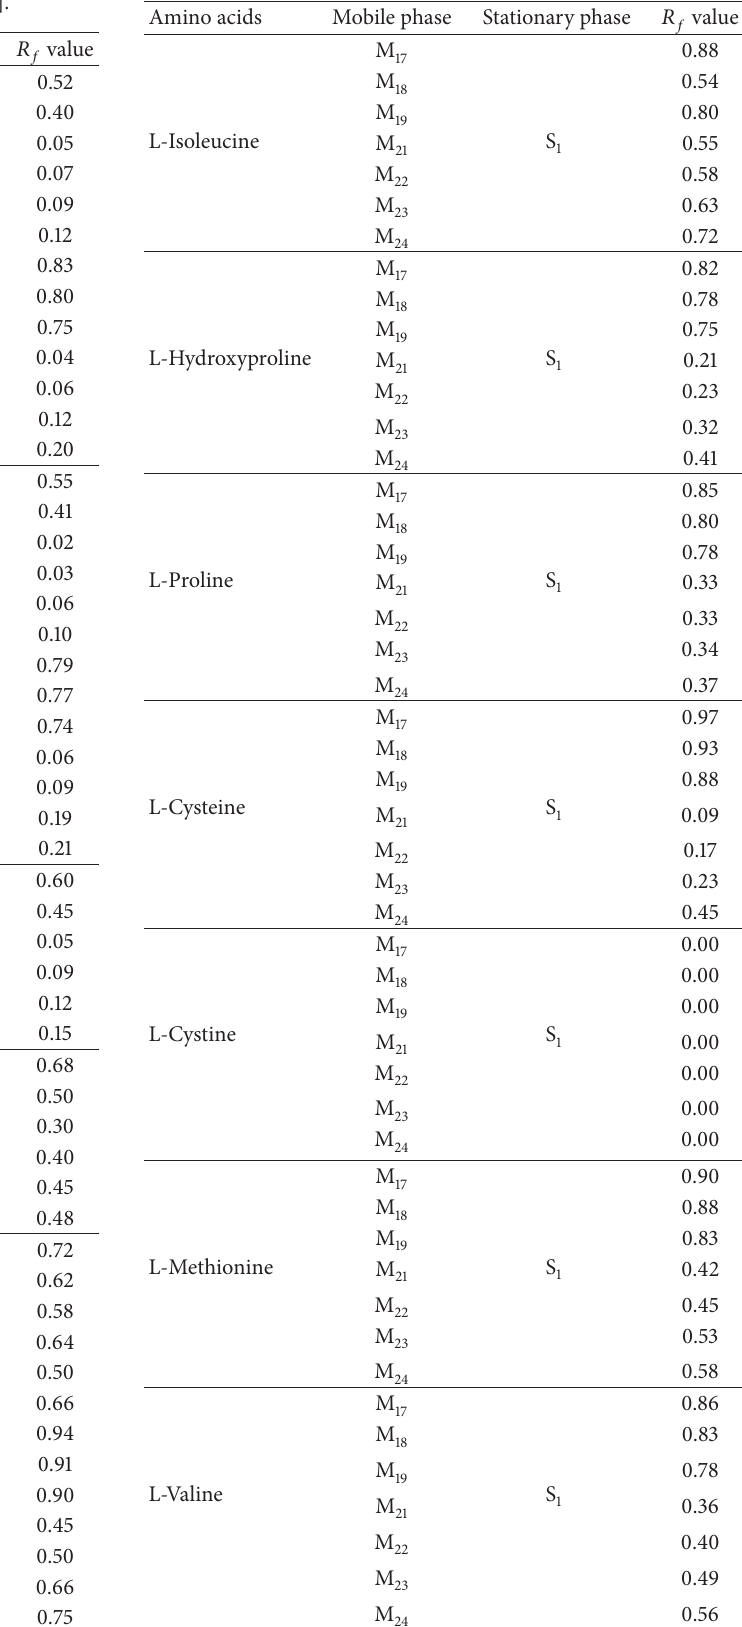
Table 4: 𝑅 𝑓 value of amino acids in different surfactants mediated solvent systems: data is extracted from references [12,